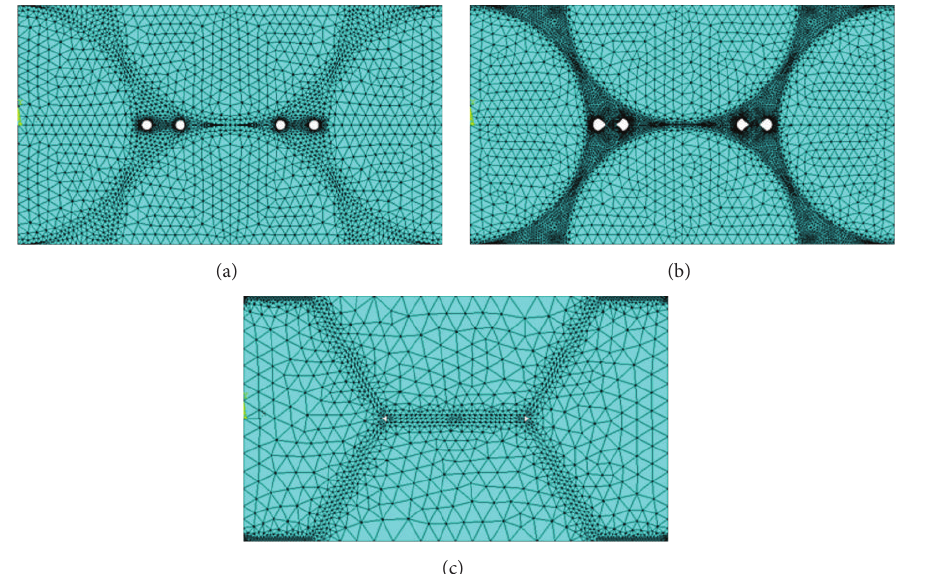
Figure 12: Mesh of models in FE environment: (a) circular pores; (b) circular pores with acute angle; (c) hexagon pores with acute angle.